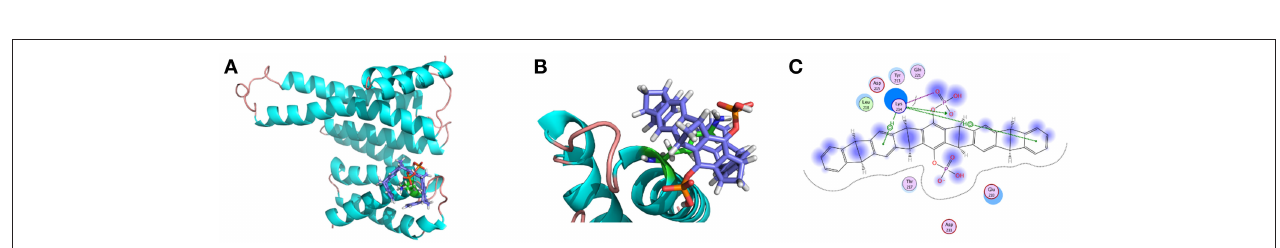
FIGURE 5 | (A) Snapshot of tweezer/K214 complex extracted from the MD trajectory of the centroid conformation of the maximum cluster of the last 200 ns. (B) Zoom-in view representation. (C) 2-D Protein-ligand interaction depictions of K214/tweezer complex by the end of MD simulation (300 ns). Green circles represent hydrophobic residues, purple circles represent polar residues, red ring represent acidic residues, and blue interior rings represent basic residues. Hydrogen bonding interactions are drawn with an arrowhead, sidechain in green and backbone in blue. Green benzol rings with a “ + ” describe an arene–cation binding; two benzol rings, an arene–arene binding. The solvent accessible surface area is plotted onto the atoms in blue smudge for ligand and over the constituent atoms as turquoise halo for receptor residues, respectively. (For detailed interpretation of the color definitions, the reader is referred to the web version of this article (Clark and Labute, 2007).